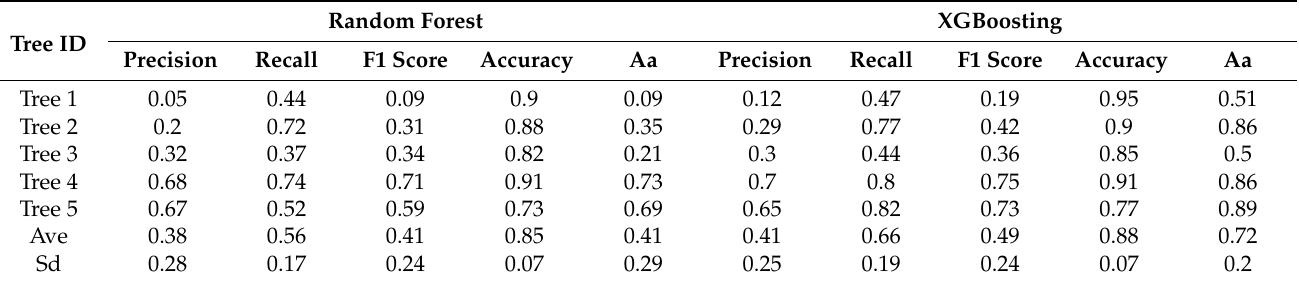
Table 4. Comparison of all performance metrics using RF and XGBoosting model; Aa, average area under the Precision–Recall curve; Ave, average; Sd: standard